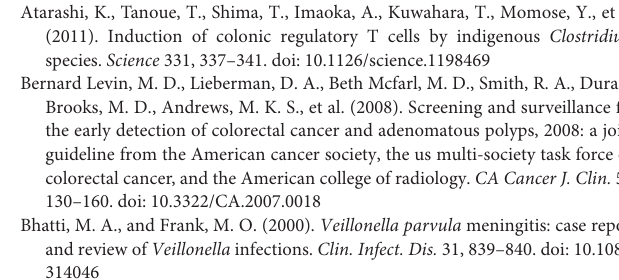
FIGURE S1 | Schematic view of the experimental design and analytical pipeline of this study. CRC, colorectal cancer; OTUs, operational taxonomic units. FIGURE S2 | Evaluation of sample preparation and sequencing quality. (A) OTU dilution curve, (B) Shannon curve, and (C) OTU rank abundance. FIGURE S3 | Heatmap representation of microbial species that were significantly different among group comparisons. FIGURE S4 | Quality of extracted DNA. FIGURE S5 | DNA gel of V4-V5 amplicon. TABLE S1 | Alpha-diversity indexes of each